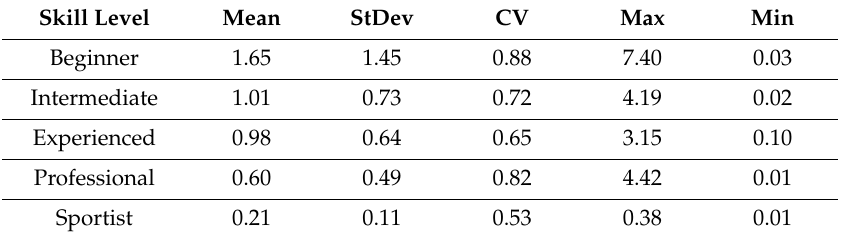
Table 2. The statistical parameters of shot angle of five shooting skill level groups